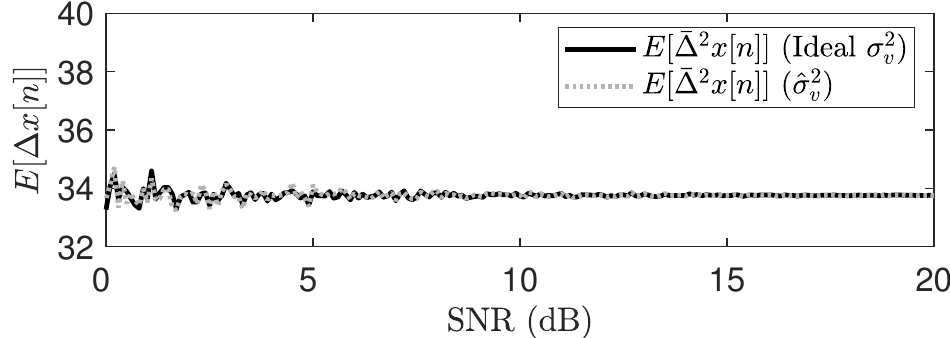
Figure 4. Feature variation based on SNR. Black solid line shows unbiased difference power obtained using ideal noise power. Gray dashed line shows unbiased difference power obtained using estimated noise